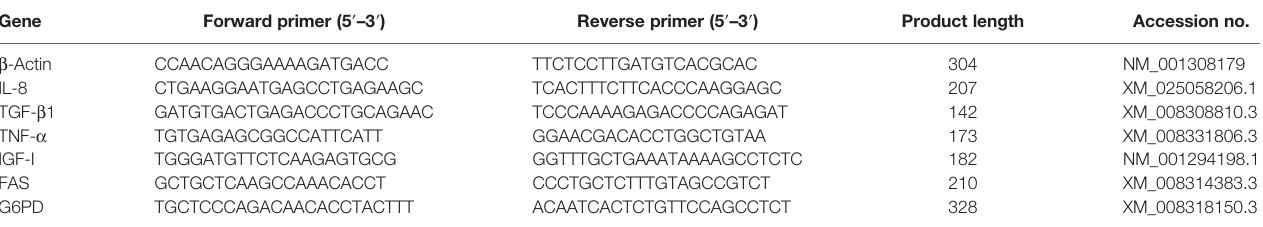
TABLE 2 | Primers used in quantitative real-time PCR (qRT-PCR).